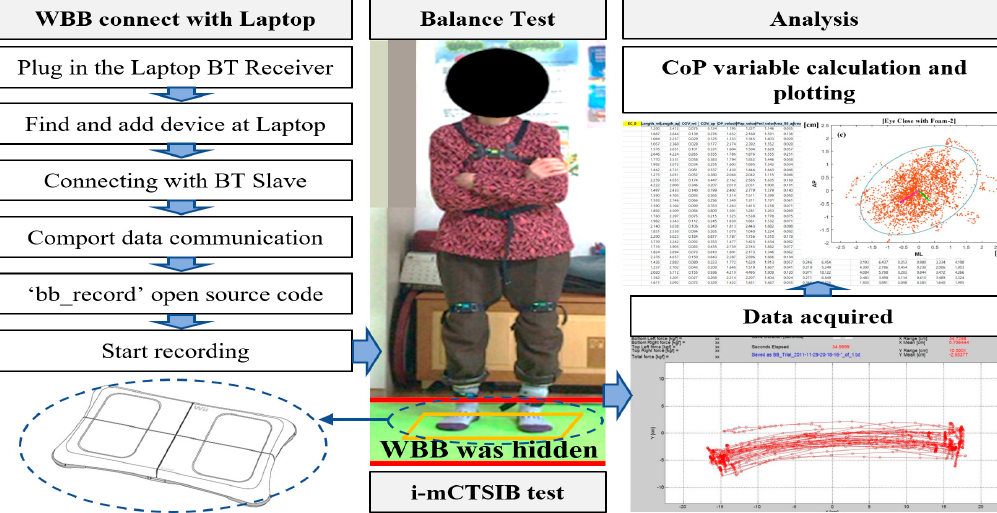
Figure 1. Components and structure of the WBB (from the Operations Manual).